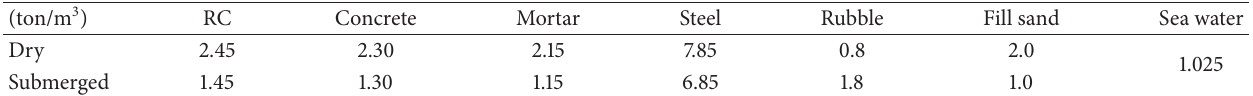
Table 3: Dead load.